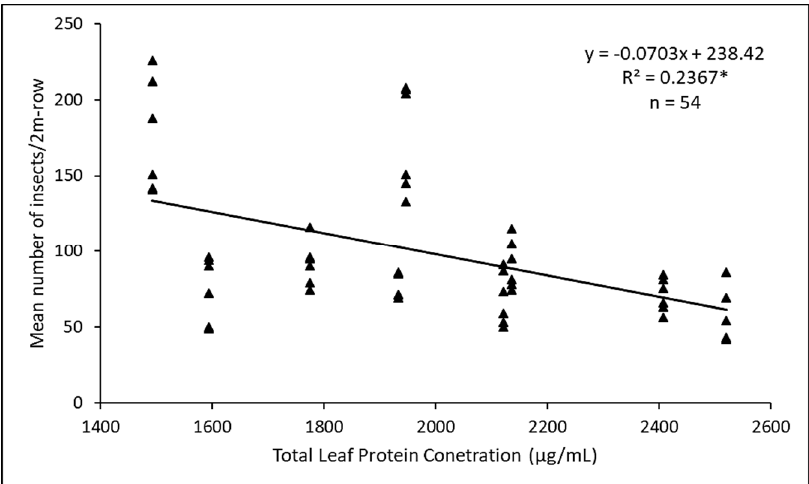
Figure 8. Regression analysis showing the relationship between total leaf protein content and D. glabrata population in 2018. * indicates significant regression coefficient at p < 0.05.